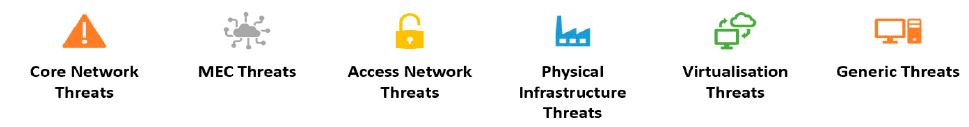
Figure 7. ENISA thematic landscape SDN/5G.